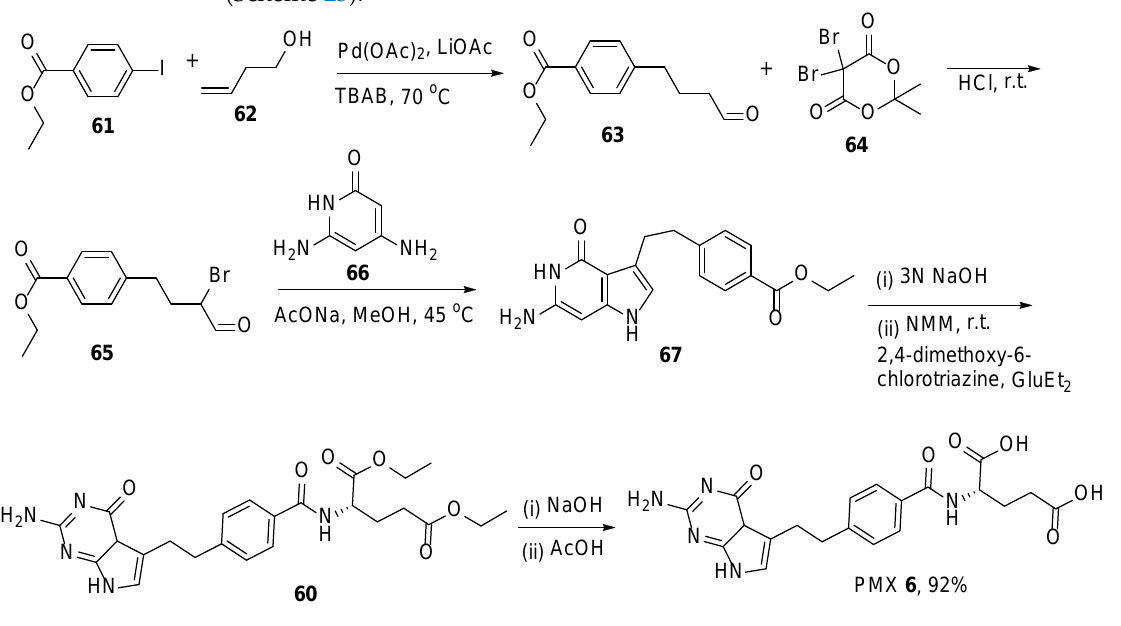
Scheme 23. Synthesis of Pemetrexed starting from ethyl 4-iodobenzoate 61 , and 1-butene-4-ol 62 through Heck cross-coupling reaction. Reproduced with the permission of reference [58]. Copyright © 2013, American Chemical